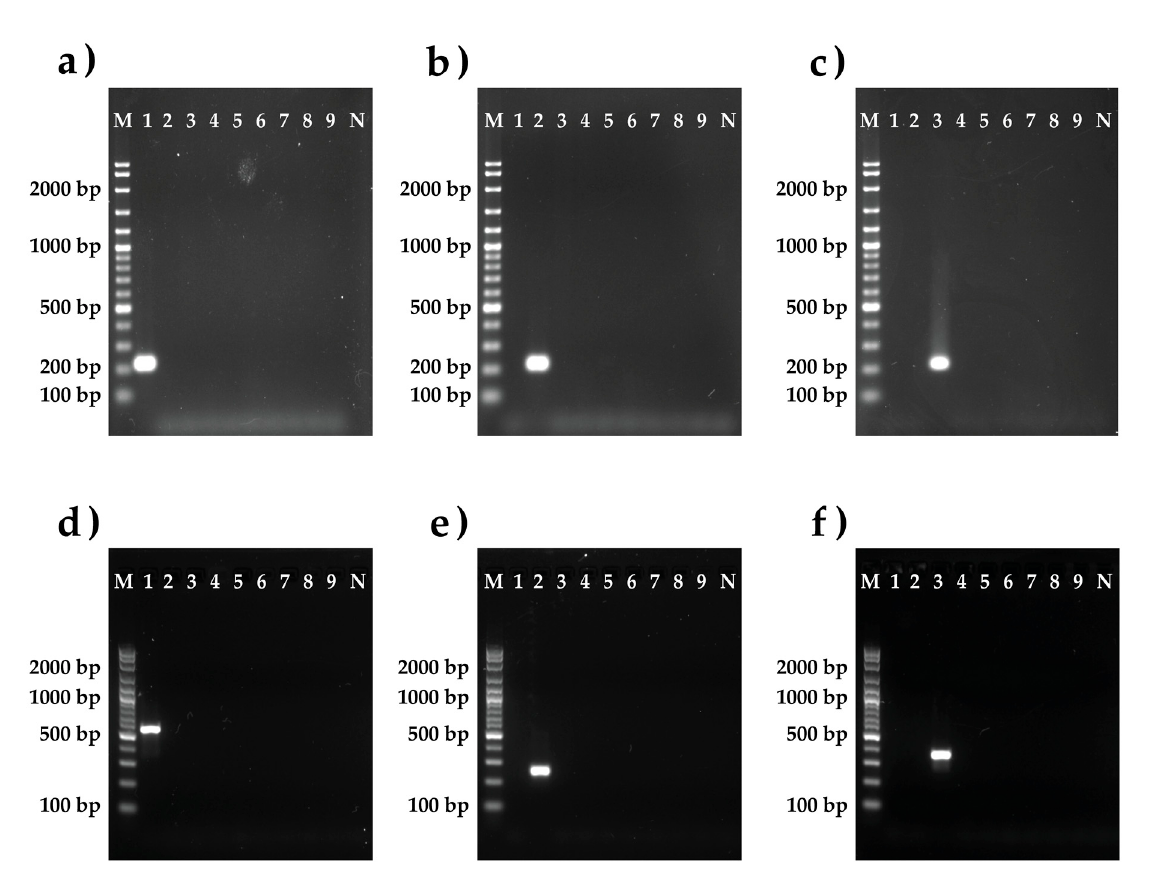
Figure 6. Gels from six PCR reactions validating the species specificity of the designed primers for three Chironex species. ( a ) 16S rRNA gene specific primers for Chironex SpA. ( b ) 16S rRNA gene Specific primers for Chironex indrasaksajiae . ( c ) 16S rRNA gene specific primers for Chironex SpC. ( d ) COI gene specific primers for Chironex SpA. ( e ) COI gene specific primers for Chironex indrasaksajiae . ( f ) COI gene specific primers for Chironex SpC. M: VC 100bp Plus DNA Ladder (Vivantis, Malaysia); 1 Chironex SpA; 2 Chironex indrasaksajiae ; 3 Chironex SpC; 4 Morbakka SpA; 5 Morbakka SpB; 6 Morbakka SpC; 7 Meteorona spp.; 8 Chiropsoide buitendijki ; 9 Copula sivickisi .; and N no template.